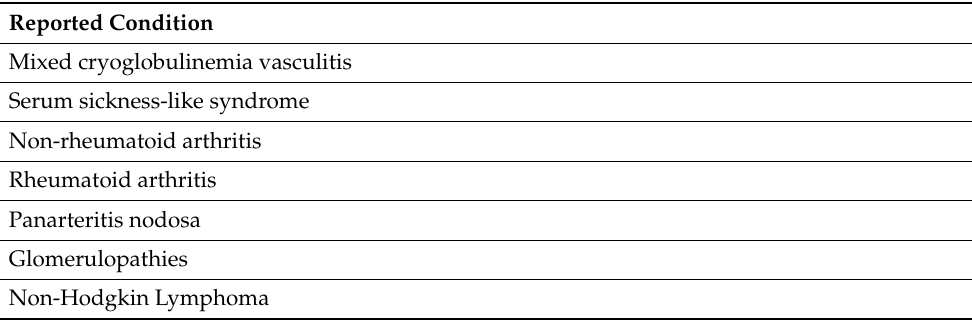
Table 1. Extrahepatic manifestations of chronic hepatitis B.